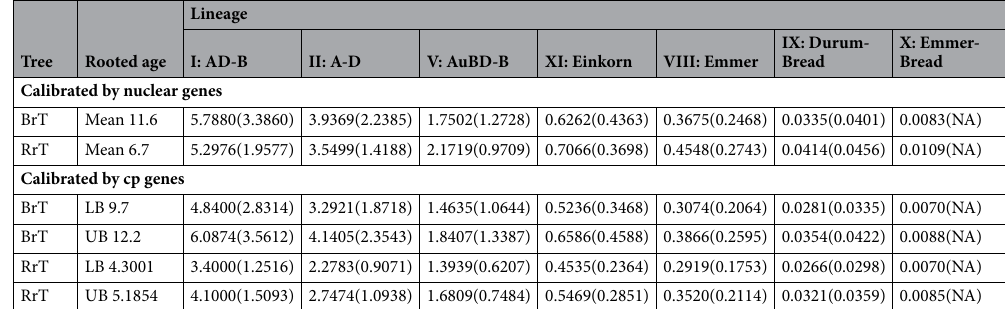
Table 4. Estimated node ages with standard deviation (in parenthesis) for seven major lineages (I: AD-B, II: A-D, V: AuBD-B, XI: Einkorn, VIII: Emmer, IX: Durum-Bread, X: Emmer-Bread wheat) for barley- and rye-rooted trees. The lineages were defined in the maternal phylogenetic trees in Fig. 3. The calibrations were made at the root age in Mya estimated from nuclear genes by Chalupska et al . 14 and chloroplast (cp) genes by Bernhardt et al . 21 . BrT is barley-rooted tree. RrT is rye-rooted tree. LB is lower bound. UB is upper bound. The standard deviation was obtained based on the estimate of height_95%_HD and scaled with the root age, but it was not obtained for the lineage X (Emmer-Bread) due to little sequence variation and labeled as not available